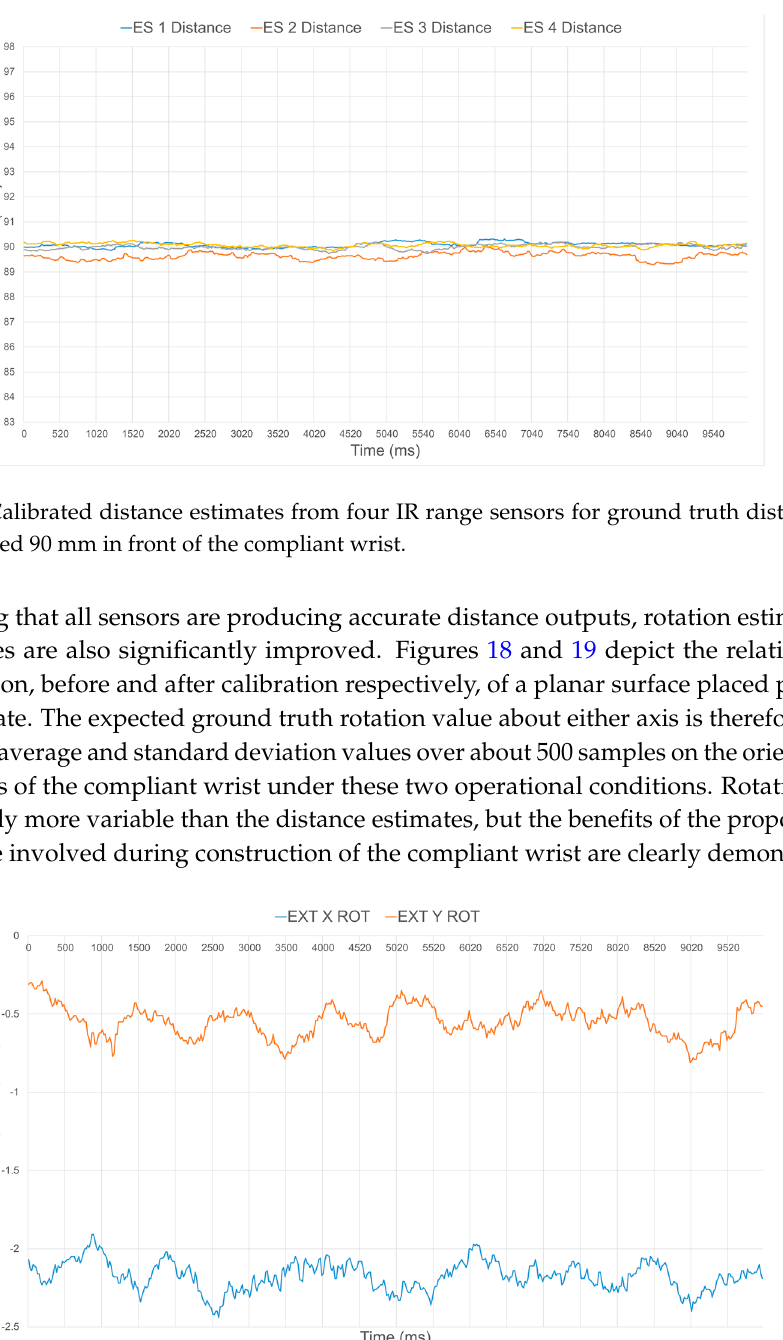
Figure 16. Uncalibrated distance estimates from four IR range sensors for ground truth distance of a surface located 90 mm in front of the compliant wrist.